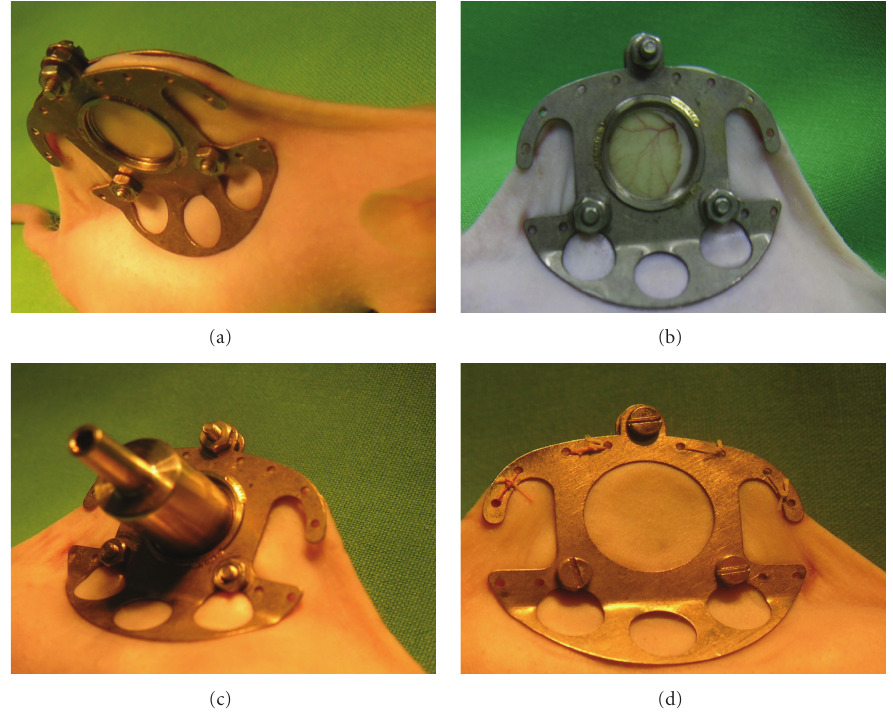
Figure 2: Steps of application of skin fold chamber. (a) Titanium frames on both sides of the skin fold; (b) circular, full-dermal-thickness wound; (c) metal cylinder containing the acceptor bu ff er (wounded side); (d) nonwounded